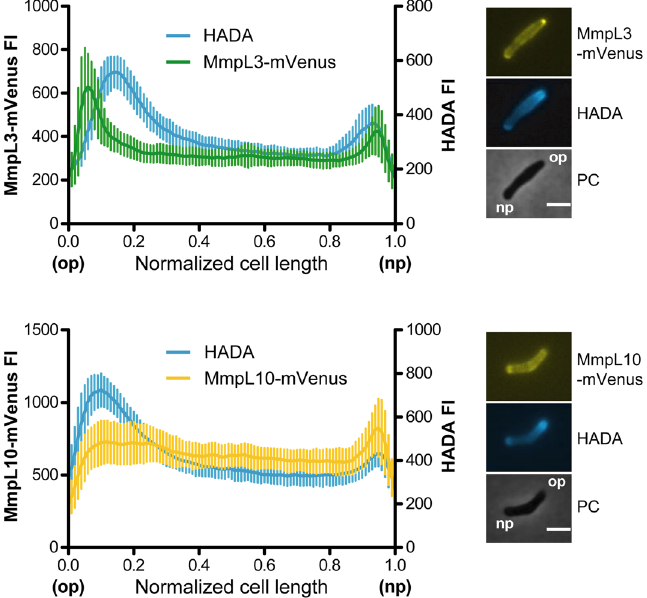
Figure 1. Fluorescence intensities (FI) of MmpL3-mVenus and MmpL10-mVenus over the long axis of M. smegmatis cells pulse-labeled with HADA. Plot profiles represent average fluorescence intensities (arbitrary units) as a function of the normalized distance to the old pole of each cell, calculated on images obtained from bacteria expressing either MmpL3-mVenus (WT/pNL3mVen, upper) (n = 20) or MmpL10-mVenus (PMM223/pNL10mVen, lower) (n = 27) labeled with HADA for 20 min. Cell poles with brighter HADA fluorescence correspond to old poles. Vertical lines represent the standard deviations of the mean fluorescence at each position along the cell axis. The graphs are representative of at least three independent experiments. Representative images of M. smegmatis cells expressing MmpL10-mVenus or MmpL3-mVenus, pulse-labeled with HADA are shown on the left (Scale bar, 2 μm). PC phase contrast, op old pole, np new